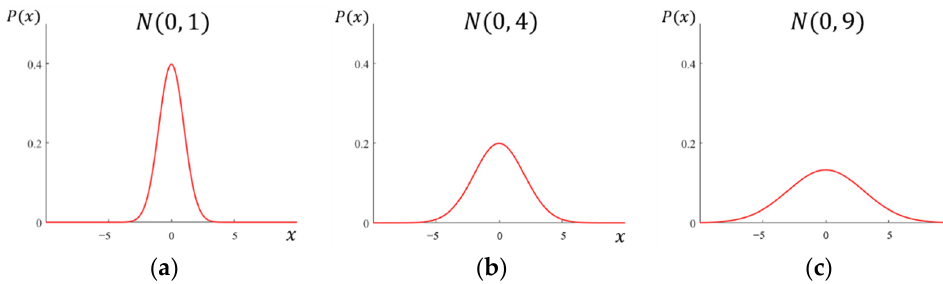
(cid:0) (cid:1) µ , σ 2 : ( a ) N ( 0,1 ) , ( b ) N ( 0,4 ) , and